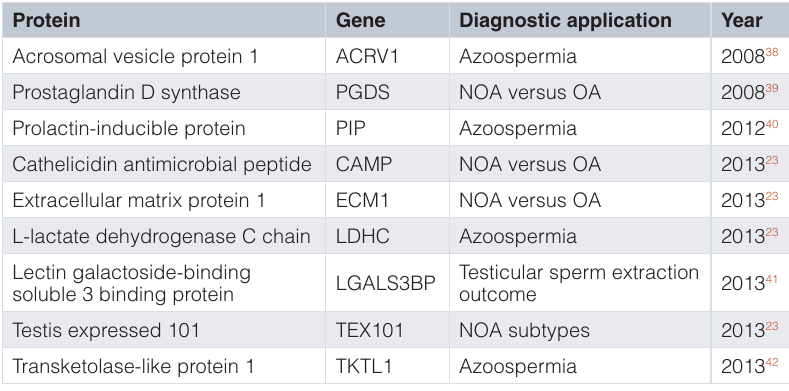
Table 1. Recently reported human male infertility